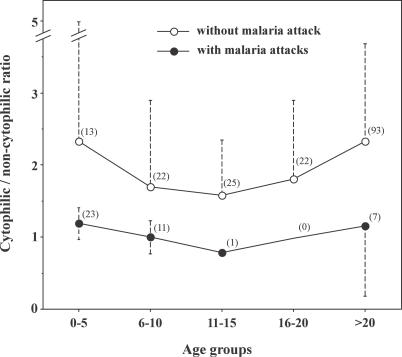
Ratios of Cytophilic to Noncytophilic Anti-MSP3 Responses Found Among Protected and Nonprotected Individuals of DielmoThe mean ratios of (IgG1 + IgG3) to (IgG2+ IgG4+ IgM) antibody responses (i.e., the cytophilic to noncytophilic [C:NC] ratios) were calculated for protected (open circles) and unprotected individuals (closed circles) within each age group. Error bars indicate the SD calculated for each age group. The number of individuals within each group is indicated in parentheses. A protected person is defined as an individual in whom no malaria attack was recorded during the first year of follow-up.